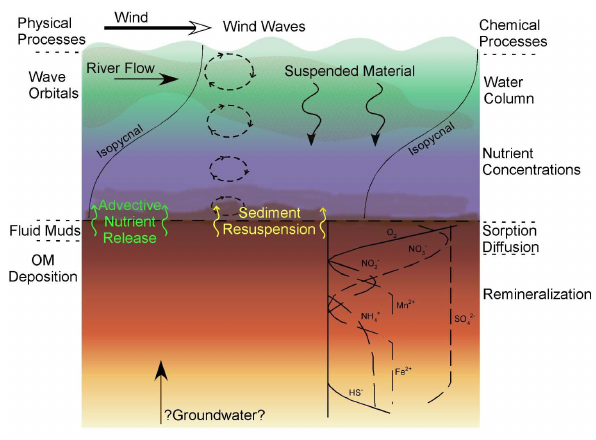
Fig. 1. Sediment processes in an estuary influence the nutrient load to surface waters. Nutrients may be introduced to the water col- umn through both passive (diffusion, desorption, etc.) and advec- tive (groundwater advection, resuspension, biological mixing, etc.) processes (modified from Giffin and Corbett,